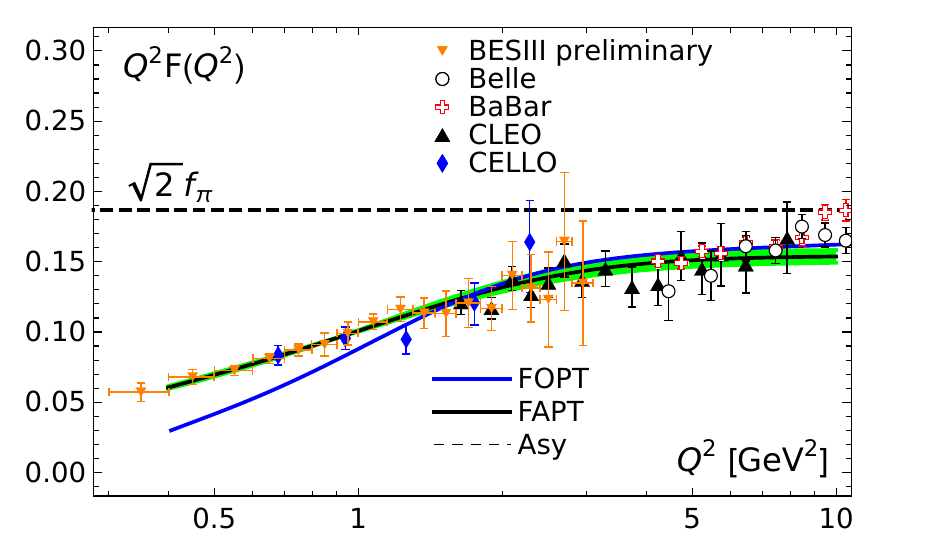
, FAPT / LCSR at the N 2 LO. The experimental FOPT / LCSR 2 defined at its upper bound 2 = (0 . 25) 6 ¯ qq ¯ qq (cid:31) (cid:30) (cid:31) (cid:30)